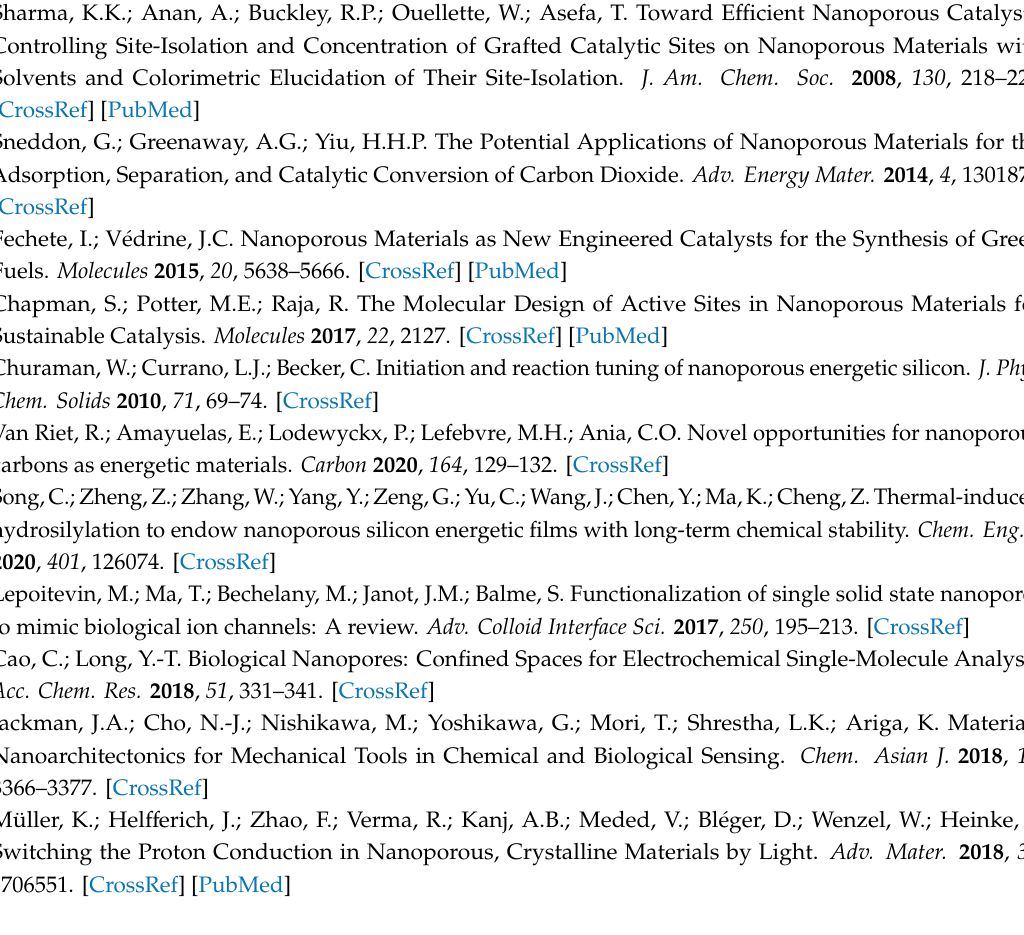
Figure S1: Evaluation of impregnation homogeneity. Figure S2: Pore size evaluation of the PSi-B from SEM top